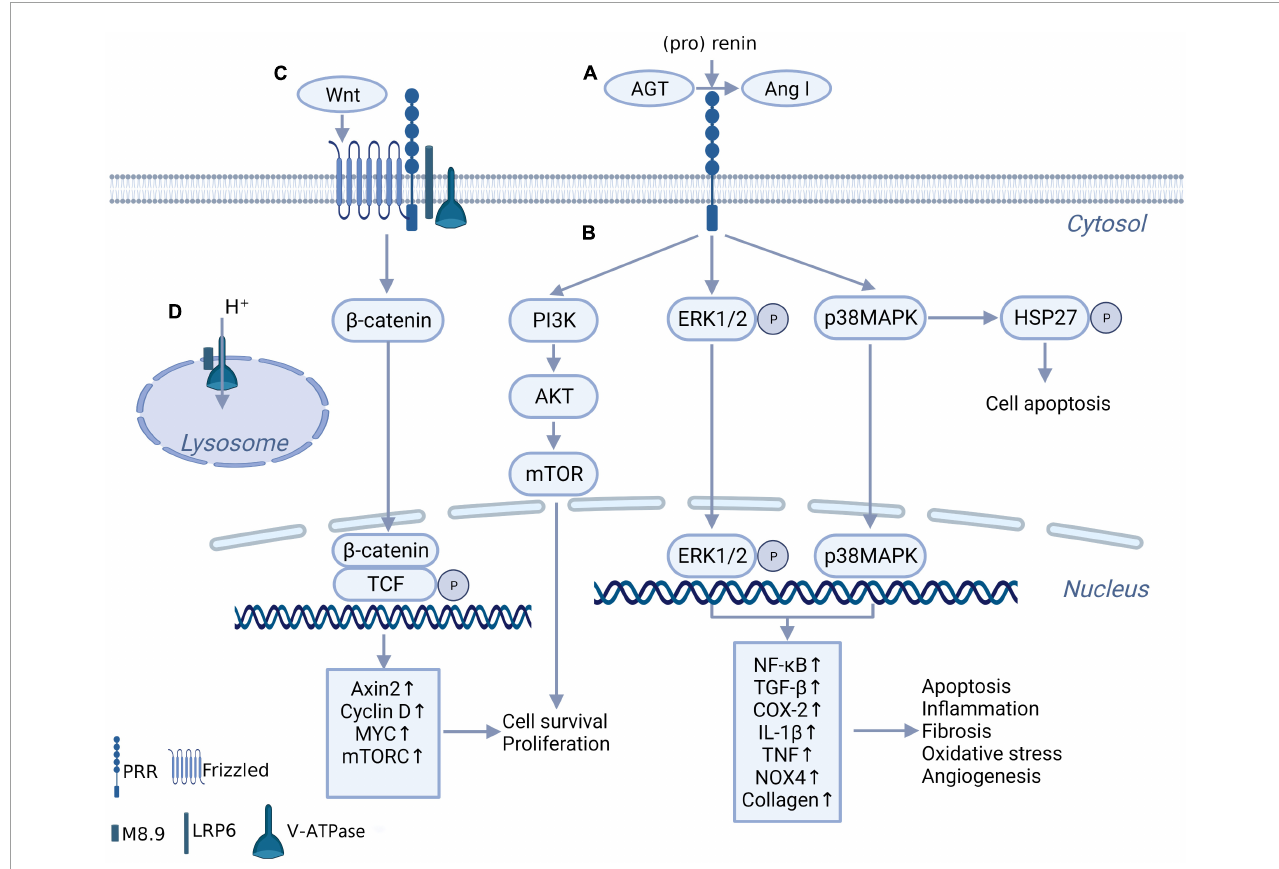
FIGURE1 The biochemical function of PRR. (A) PRR convert AGT to Ang I through binding with (pro) renin, independent of renin. (B) When bind with renin and (pro) renin, PRR promotes multiple intracellular pathways, include ERK1/ERK2 pathway, p38MAPKs-HSP 27 pathway and PI3K-AKT pathway, and further promotes downstream transcription factors expression. (C) PRR constitutes Wnt receptor complex together with Frizzled, H + -ATPase and LRP6, takes part in Wnt/ β -catenin pathway. (D) The truncated form of PRR named M8.9 is an important part of H + -ATPase, contributes to normal lysosomal